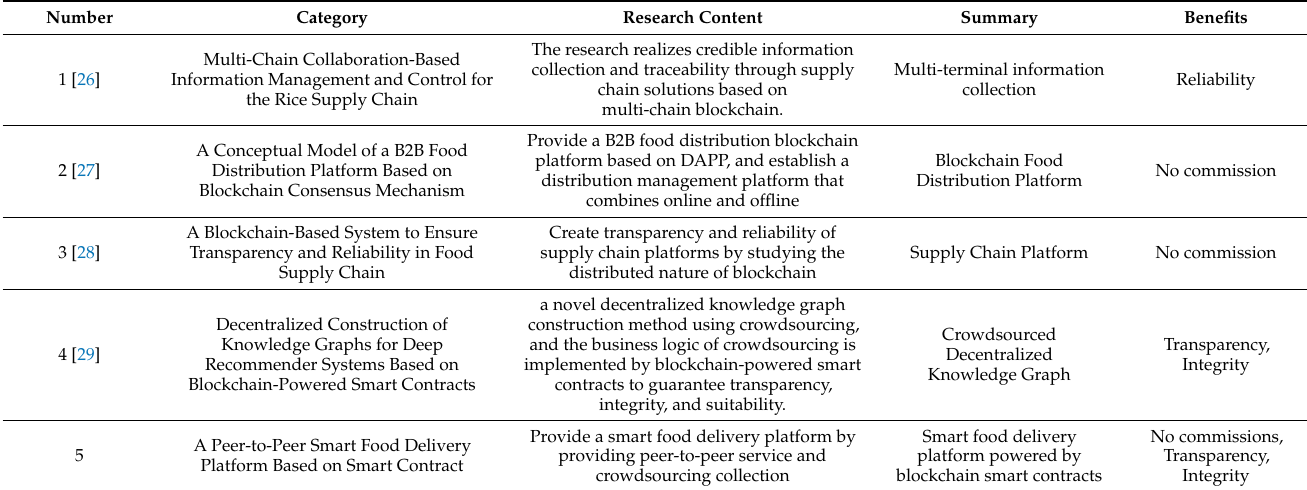
Table 2. A Comparison of Platform-Based Blockchain